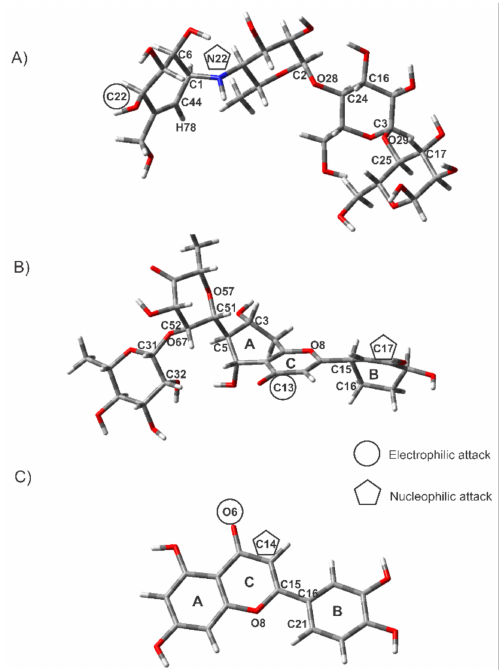
Figure 1. Optimized molecular structure of the ligands at the M06/6-31G(d) level of theory: ( A ) acar- bose (ACA), ( B ) maysin (MAY), and ( C ) luteolin